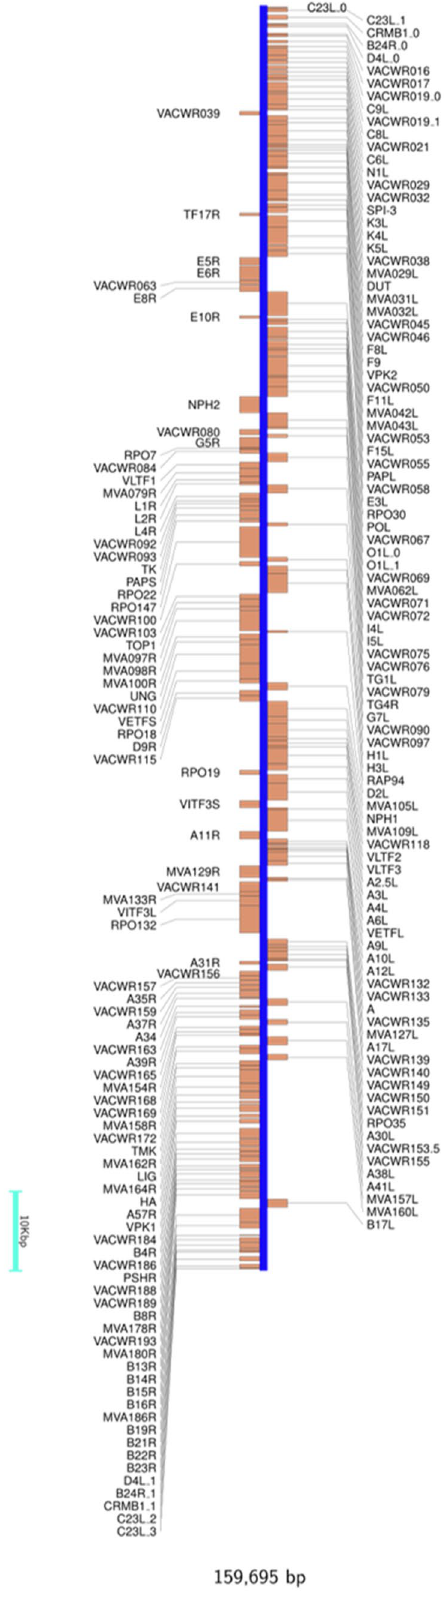
Figure 3. Annotated Ducapox gene map. The genome contained a total of 186 predicted